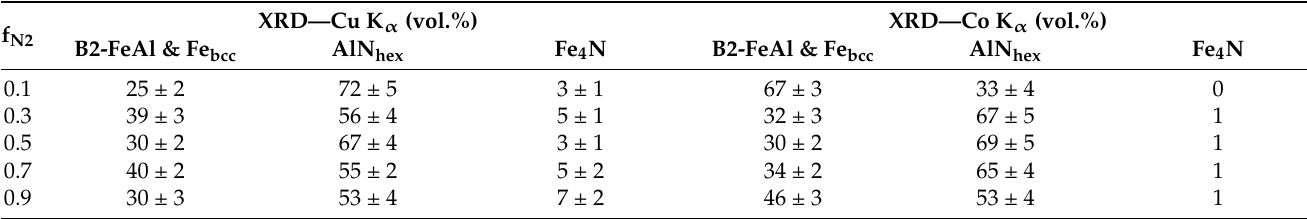
Table 2. Phase composition of the nitrided layer obtained from XRD